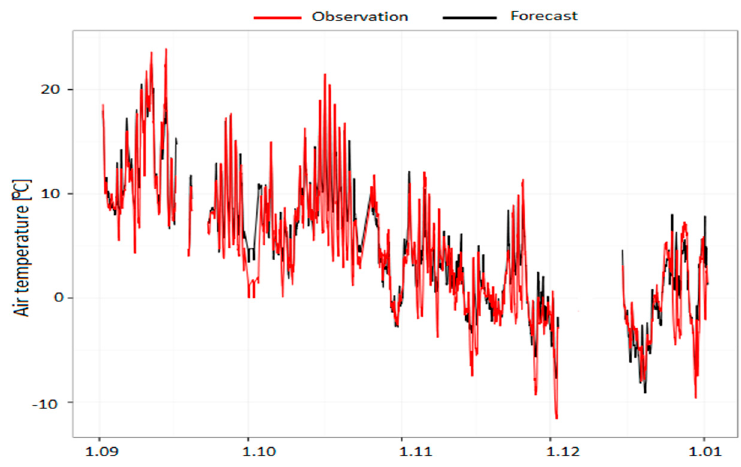
Figure 7. Measured and modeled values of air temperature (2 m above the ground) at Zakopane station for the period 01 September to 31 December 2017 for AROME CMC 2 km.